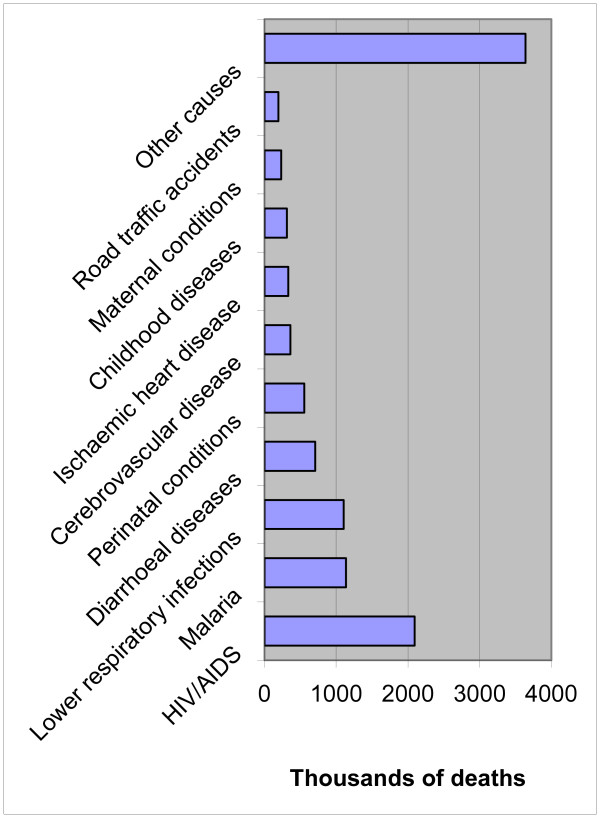
Leading causes of death in the WHO African Region. Source: WHO [1].